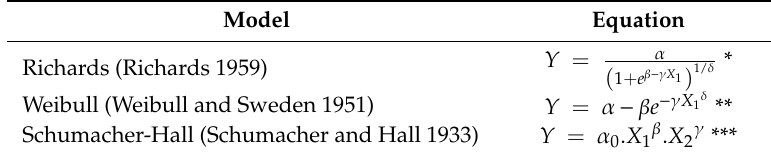
Table 3. Non-linear models and their equations used to estimate the biomass and nutrients in the eucalypt stand.